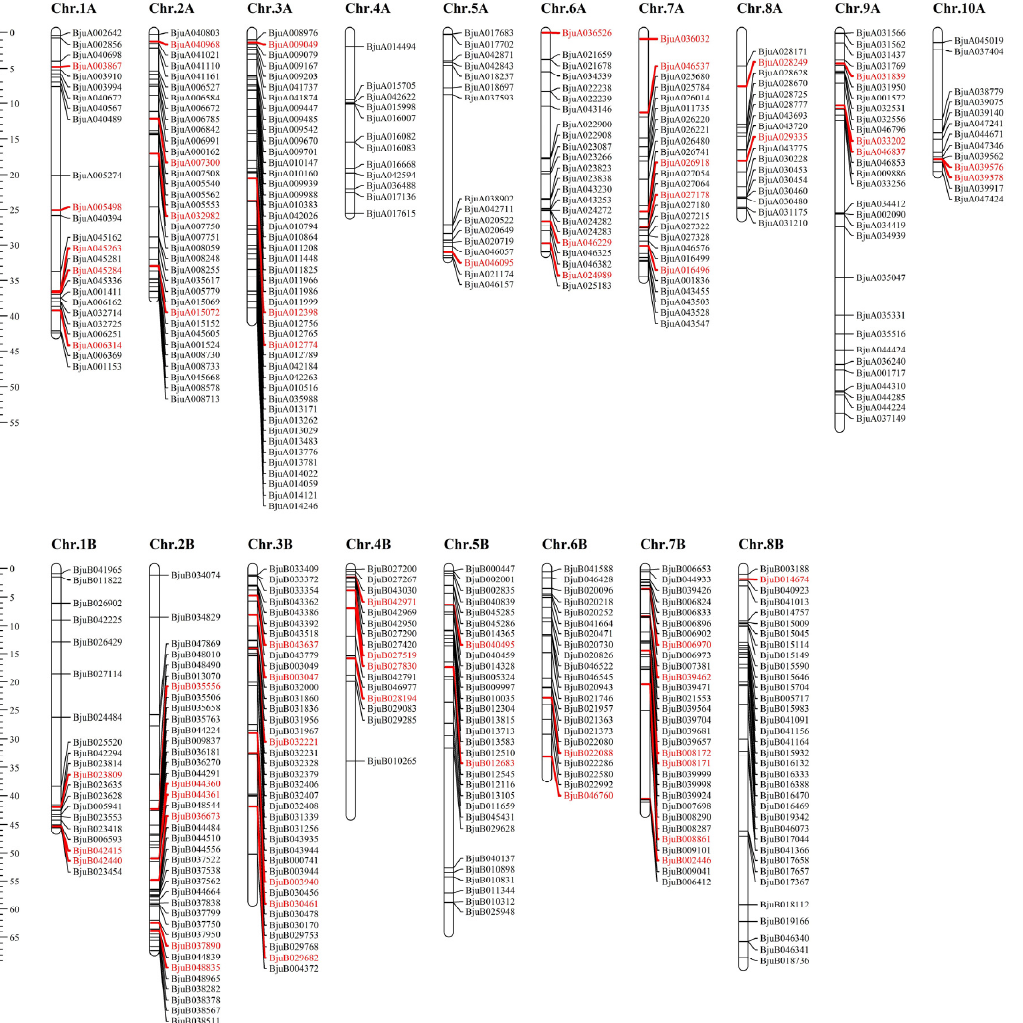
Figure 2. Distribution of the identified MYB transcription factors genes on 18 chromosomes of Brassica juncea . Chromosome numbers are indicated at the top of each bar and chromosomal distances are given in Mbp at the left of each bar. The MYB genes from the C1 group are labeled in red, while the other members of MYB genes are labeled in black.